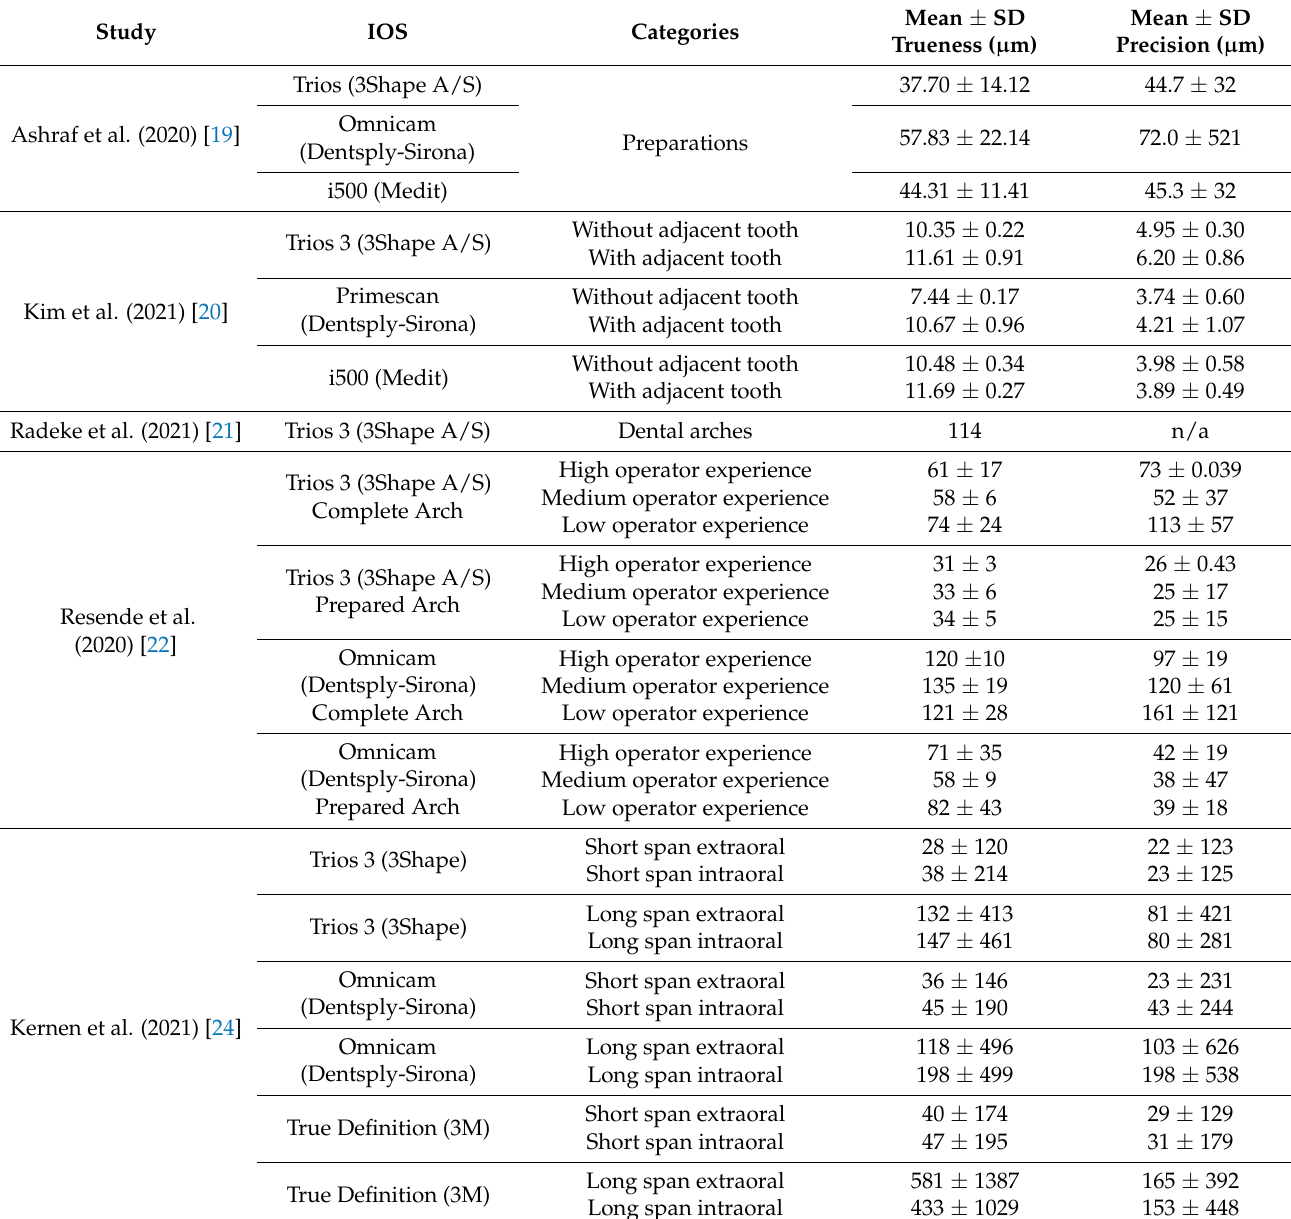
Table 2. Table of articles showing general trueness in relation to desktop/industrial